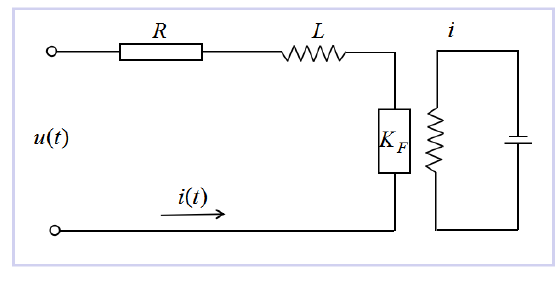
Figure 6. Model diagram of voice coil actuator.